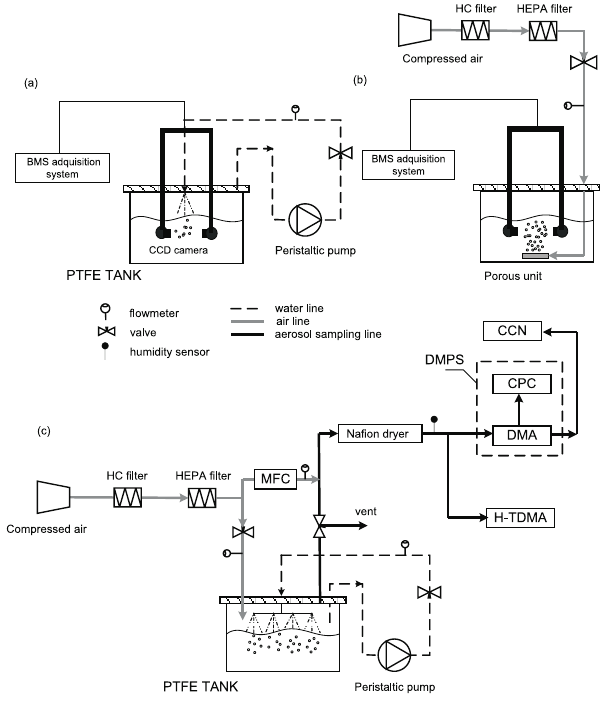
Fig. 1. Schematic of bubble spectrum experiments for (a) the plunging-water jet system and (b) porous media bubblers. (c) Experimental set-up for aerosol size distribution, hygroscopic- ity and CCN experiments (the schematic represented corresponds to the plunging-water jet system). BMS=bubble spectrome- ter, DMPS=differential mobility particle sizer, DMA=differential mobility analyzer, CCN=cloud condensation nuclei counter, CPC=particle counter, H-TDMA=Hygroscopic-tandem differential mobility analyzer, MFC=mass flow